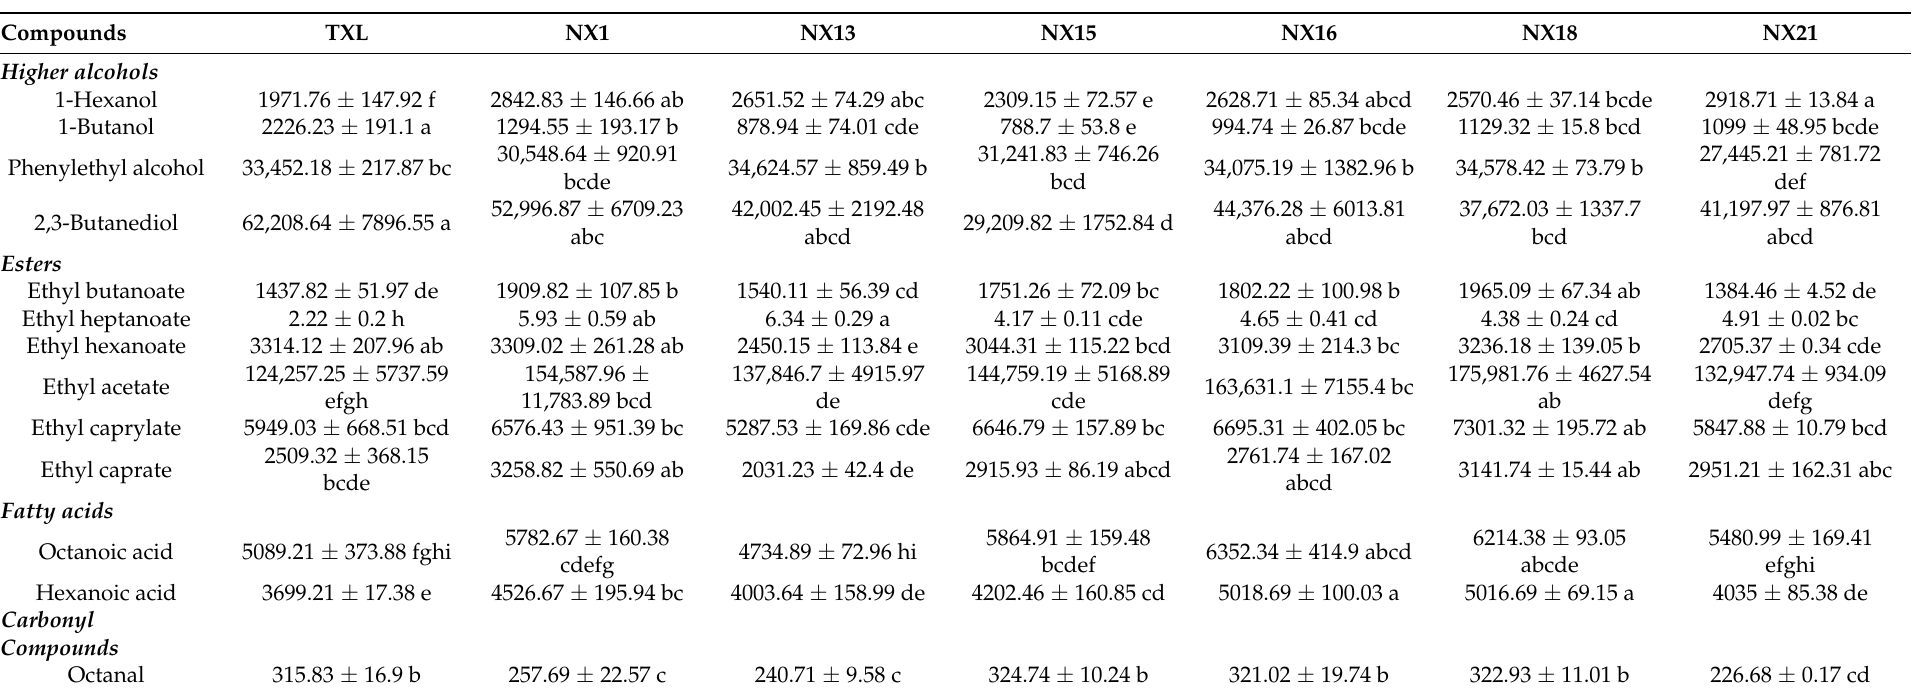
Table 3. Concentrations ( µ g/L) of volatile compounds with OAV > 1 in Chardonnay fermented by the indigenous S. cerevisiae strains and the commercial strain